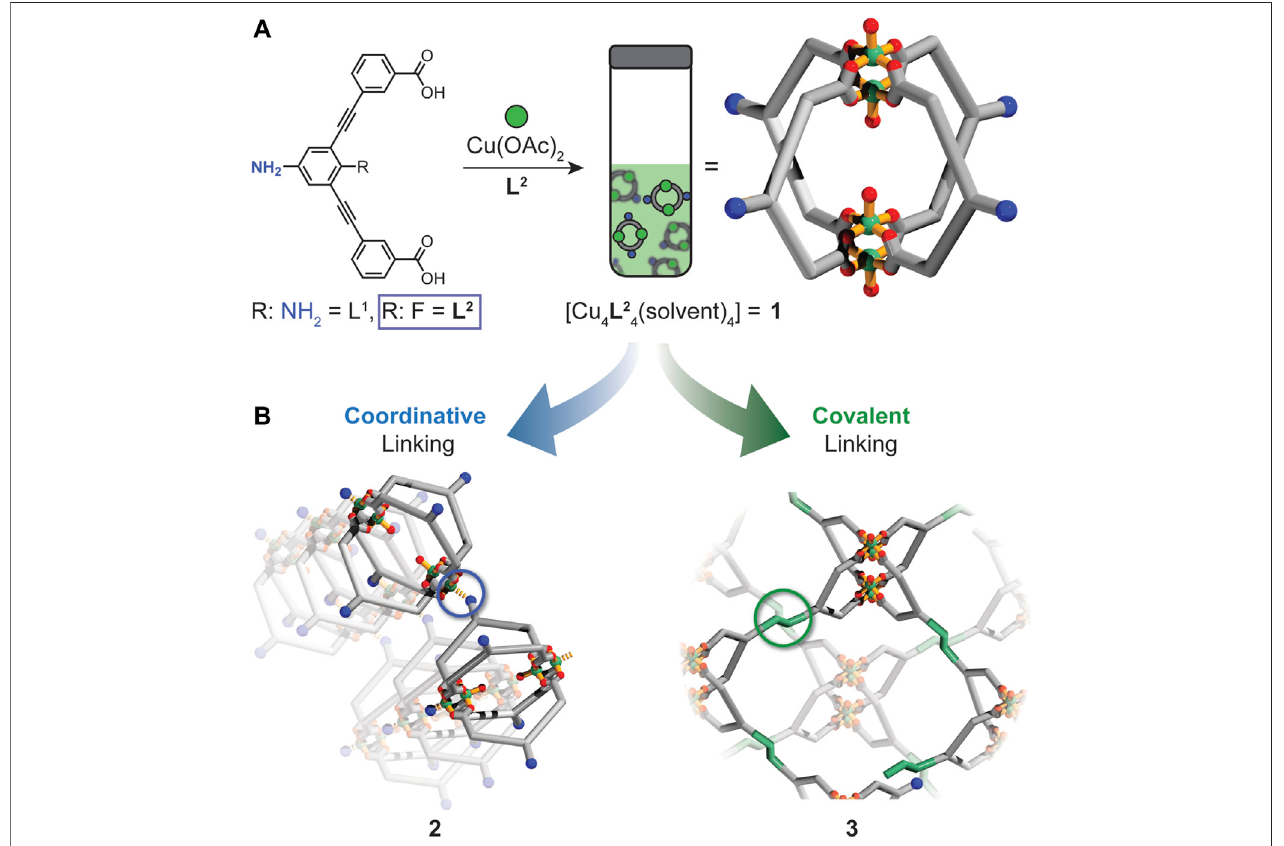
FIGURE1|(A) Solutionself-assemblyof 1 from L 2 andCu(OAc) 2 inDMForDMA. (B) Theexterioramineof 1 canbehaveasadonorornucleophiletolink 1 intotwo different types of metal-organic cage polymers ( 2 or 3 ).